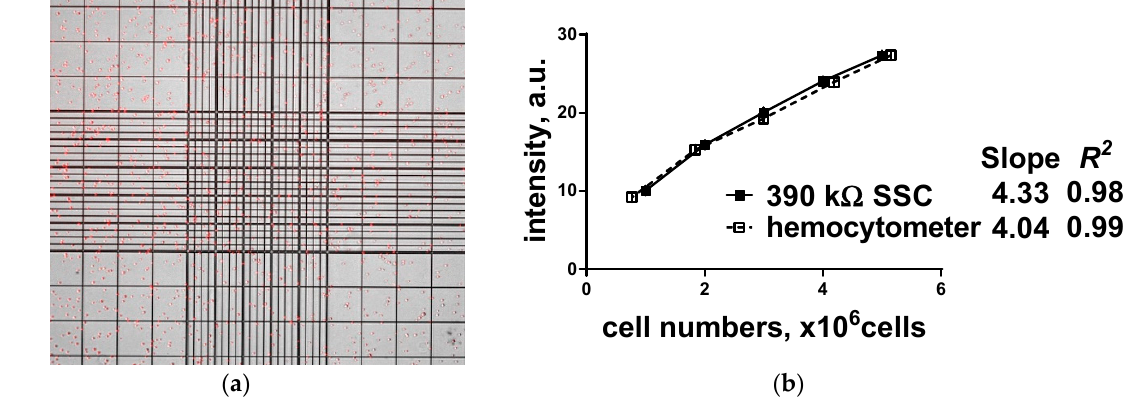
Figure 7. Representative R6G treated images of HeLa cells on the ruled hemocytometer chamber under a fluorescence microscope and its performance results: ( a ) merged image of bright field image and fluorescently labeled HeLa cells; ( b ) fluorescence intensity of HeLa cells using 390 k Ω load resistor with no excitation filter, but only emission filter (center wavelength (CWL) at 500 nm).